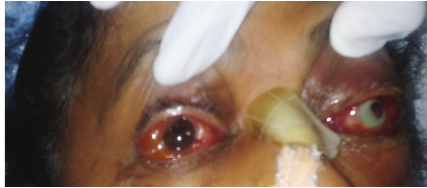
Figure 1: Bedside torch light examination showing corneal infiltrate in the left eye and conjunctival redness and suffusion in both eyes.